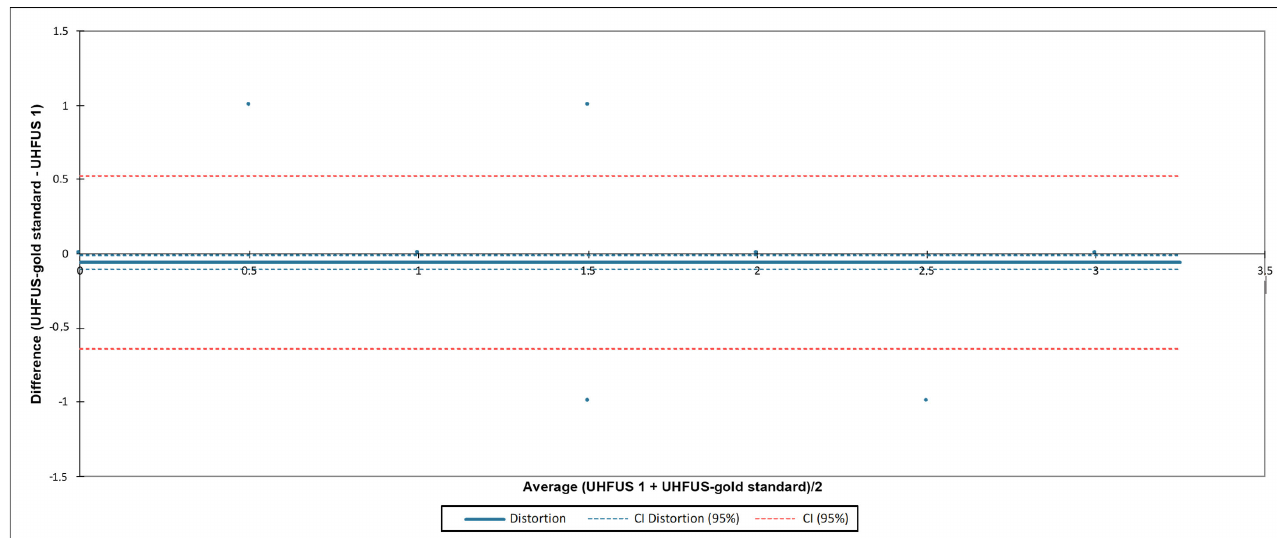
Figure 2. Bland-Altman test evaluating the agreement between the first reader (UHFUS 1) and the gold standard examiner (UHFUS-gold standard). The 95% confidence interval (CI) of the distortion was ( − 0.101;